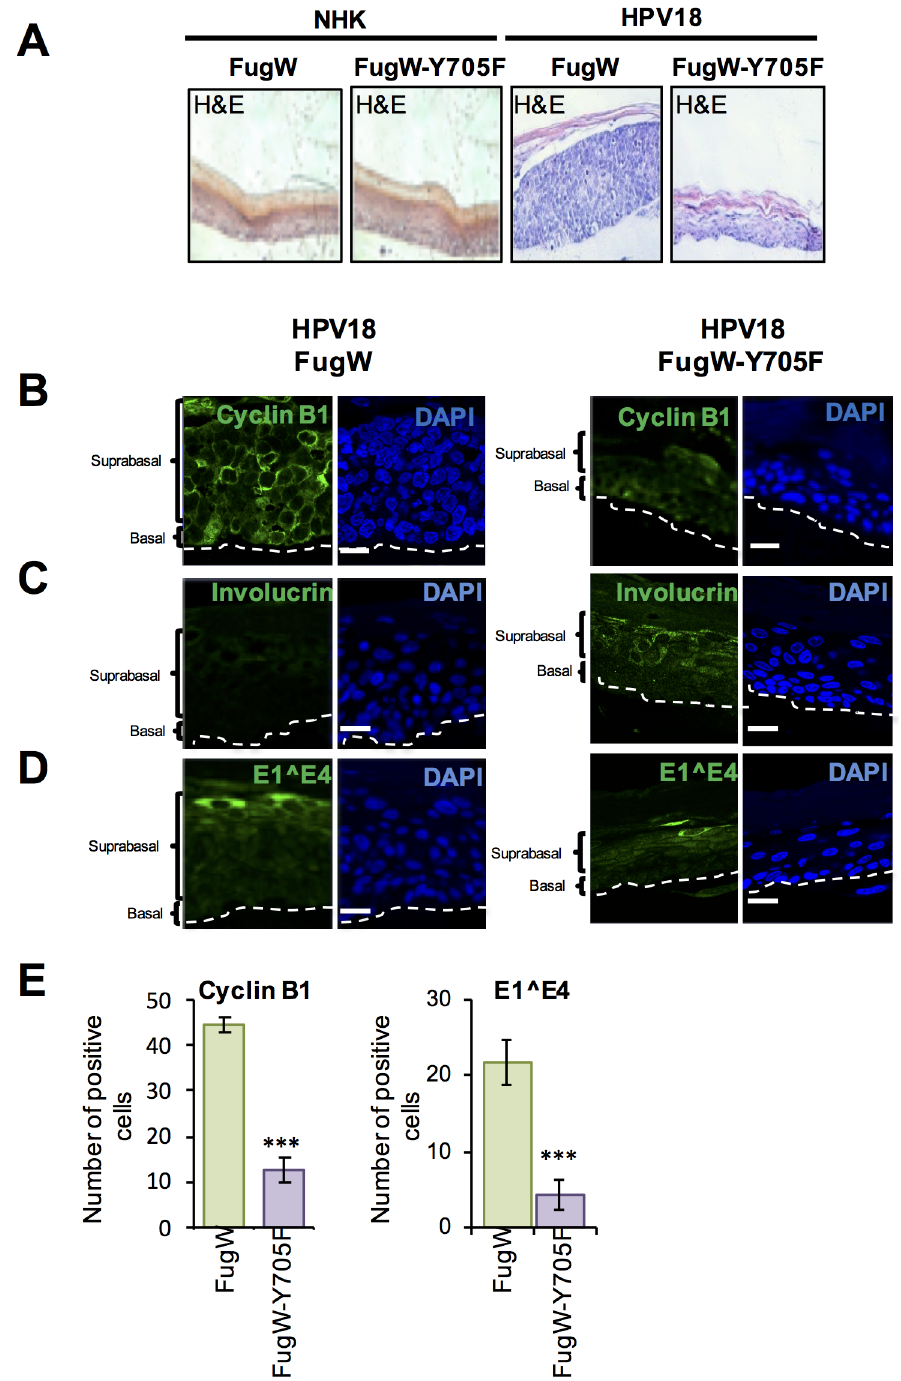
Fig 9. STAT3 is necessary for delayed differentiation and increased keratinocyte proliferation in a stratified epithelium. A) Representative organotypic raft cultures of NHK and HPV18-containing keratinocytes transduced with empty lentivirus and lentivirus expressing a dominant negative phosphorylation null Y705F mutant STAT3 fixed at day 14 and stained with haematoxylin and eosin (H&E) to assess morphology. Sections were also stained with antibodies specific for B) cyclin B1 C) involucrin and D) E1^E4. Nuclei are visualised with DAPI (blue) and white dotted lines indicate the basal cell layer. E) The number of cells positive for cyclin B1 and E1^E4 in the empty vector and Y705F STAT3 transduced HPV18-containing keratinocyte sections was counted in 5 fields of vision from sections of three independent raft cultures from two donor lines. Bars represent means ± standard deviation. (cid:3)(cid:3)(cid:3) P < 0.001 (Student’s t-test) compared to empty vector